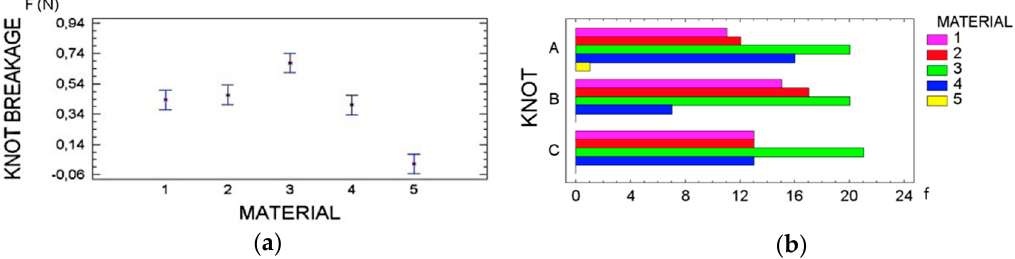
Figure 6. ( a ) Failure load of knots according to each suture material. ( b ) Frequency of knot breakage in relation to suture material and knot configuration used.